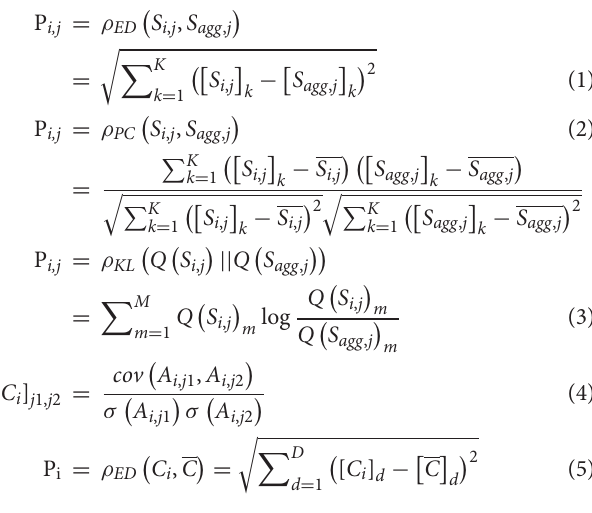
reference pattern in this preliminary analysis, we repeated the above analysis using a balanced subcohort of 134 patients and 134